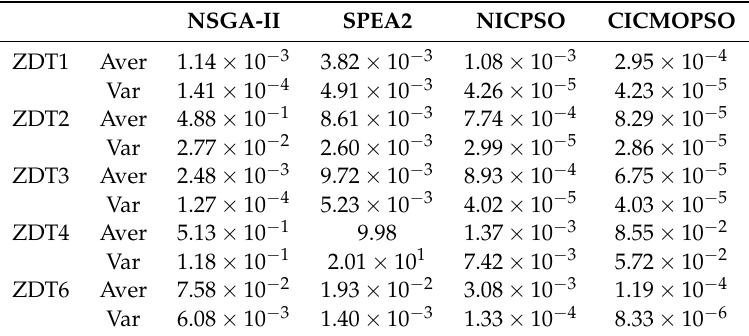
Table 4. Comparison of results for the convergence index